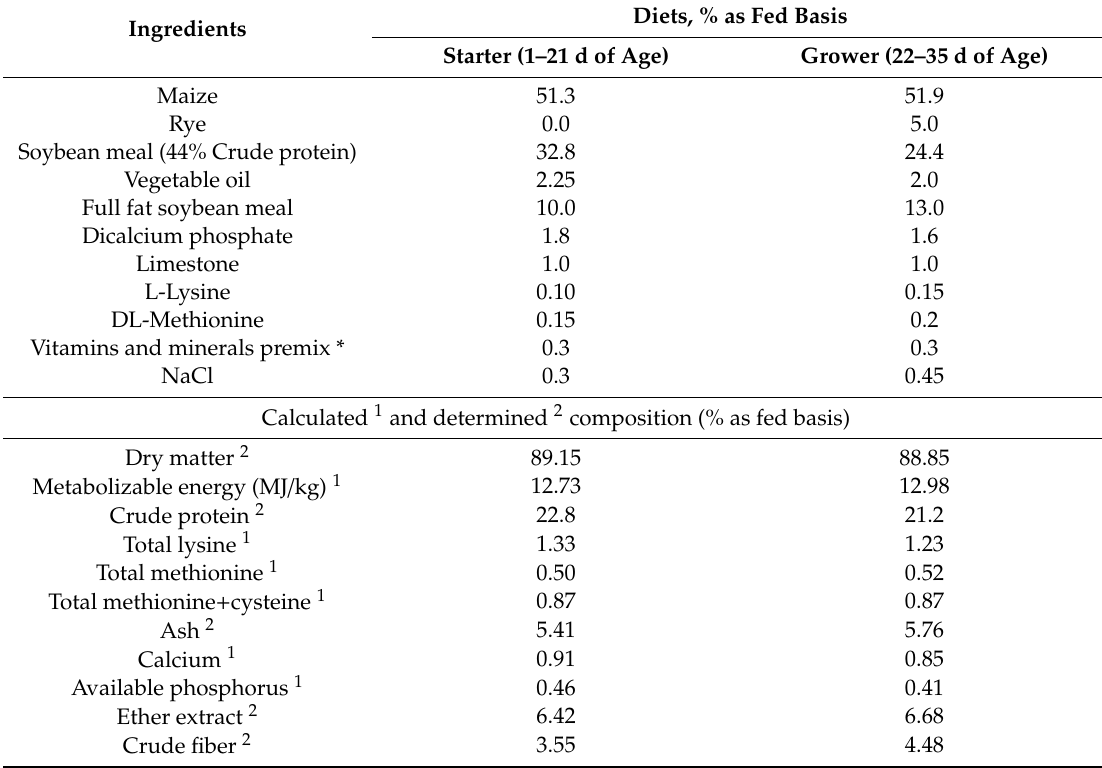
Table 1. The ingredients and determined and calculated composition of the experimental